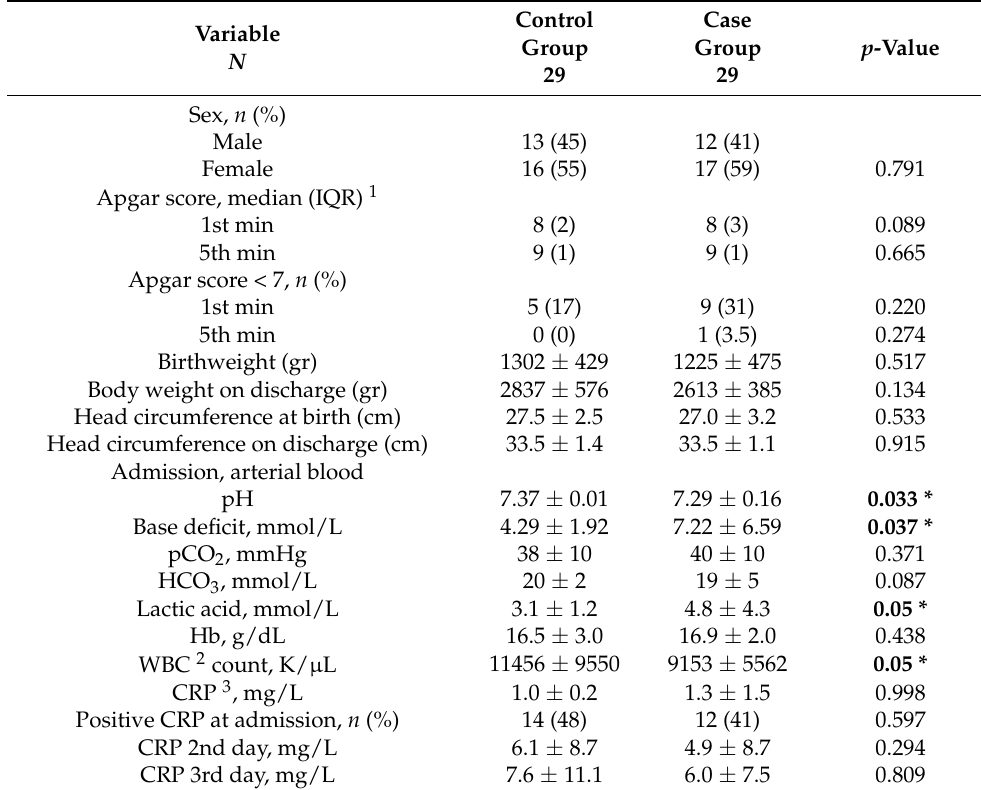
Table 2. Neonatal demographic—clinical characteristics and laboratory findings of neonates in the control and case group [22].